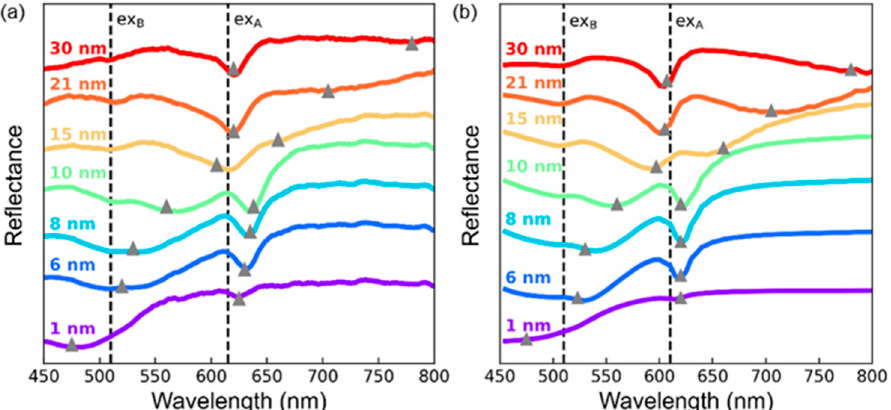
Figure 3. ( a ) Measured and ( b ) TMM-calculated thickness-dependent reflectance spectra of WS 2 flakes on the Au films. The dashed lines indicate the exciton resonance wavelengths of WS 2 multilayers. The gray triangles represent the EP-induced reflectance dips.